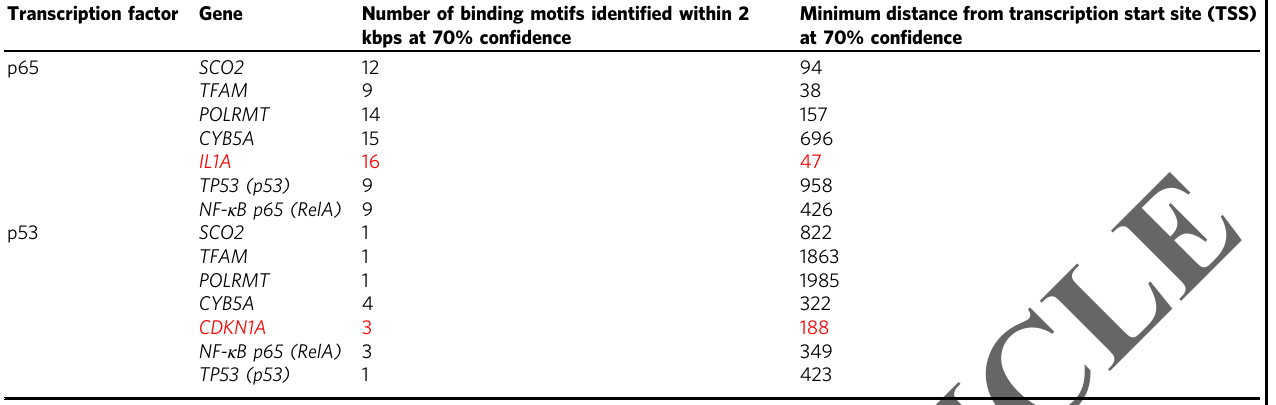
Table 1 Bioinformatic analysis of putative-binding motifs for NF- κ B and p53 Transcription factor